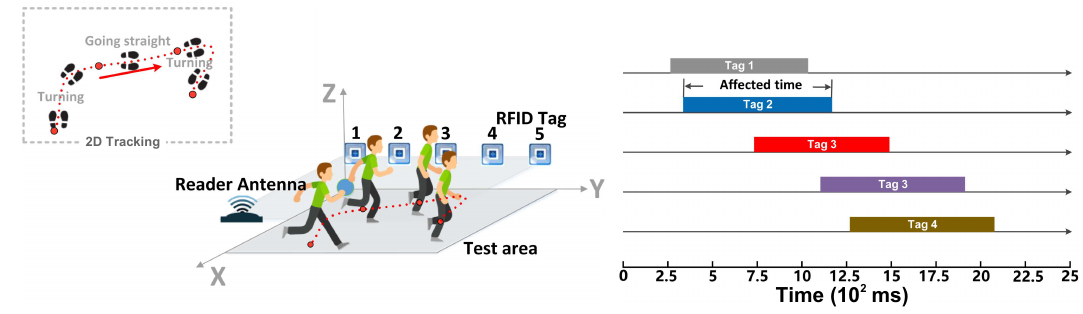
Figure 1. The function of